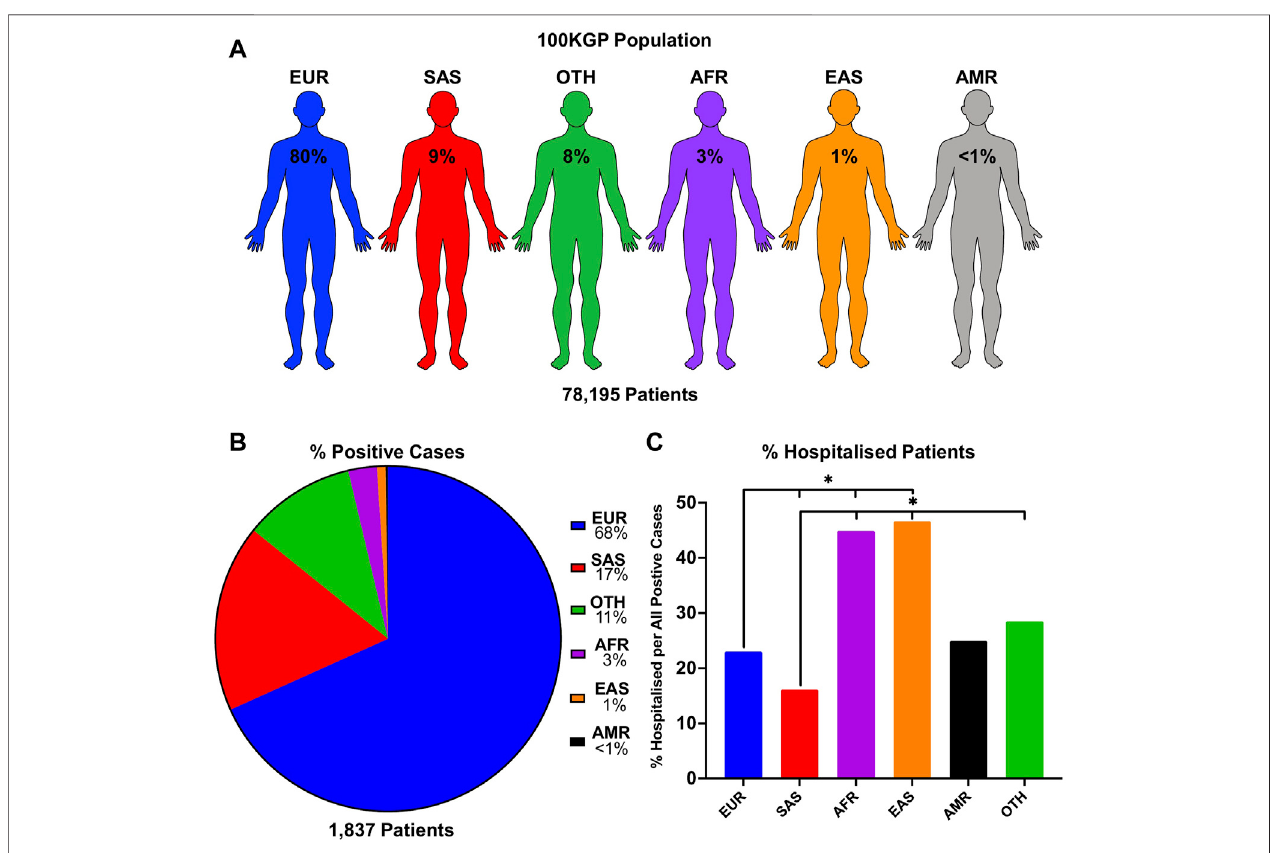
FIGURE 1 | SARS-CoV-2 infection numbers and hospitalisation rate per ethnic group in the United Kingdom population. (A) The proportion of individuals in each population of the entire 100KGP cohort was assigned with a probability of > 0.8 for any one ancestry. (B) Percentage of patients who tested positive for SARS-CoV-2 presented as positive cases in each ethnic background relative to the total positive cases in the 100KGP. (C) Percentage of hospitalised patients per total positive individuals in each ethnic group. p values are calculated using the Chi-square test.